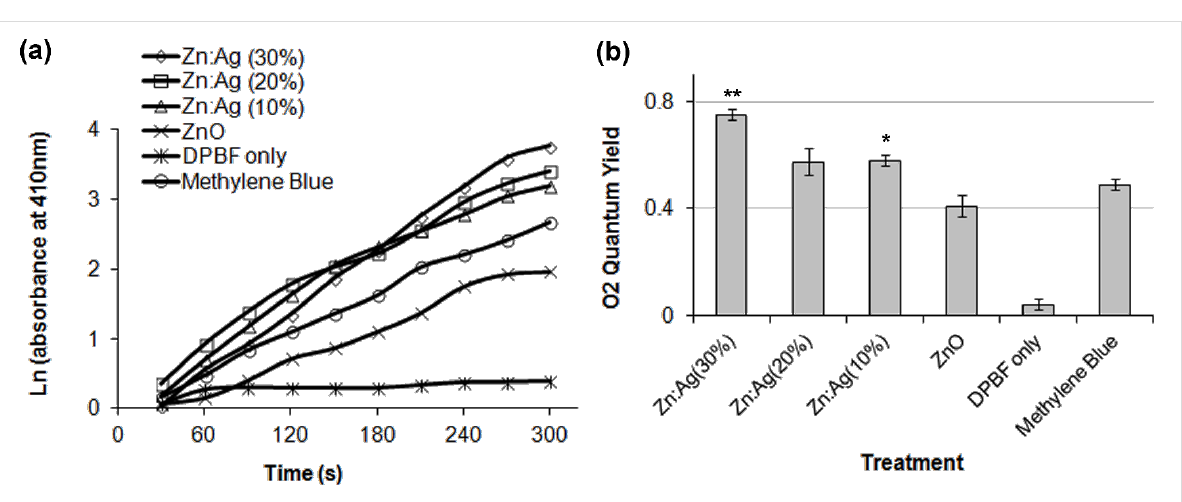
Figure 6: Consumptions of the singlet oxygen indicator DPBF mixed with ZnO and ZnO:Ag nanocomposites under the exposure to light and recorded every 30 s. (a) Time course of the natural log of absorption spectrum of DPBF at 410 nm. (b) Quantum yield (mean ± SD) of singlet oxygen. * p < 0.01, ** p < 0.0001 (two tailed t-test) in comparison to